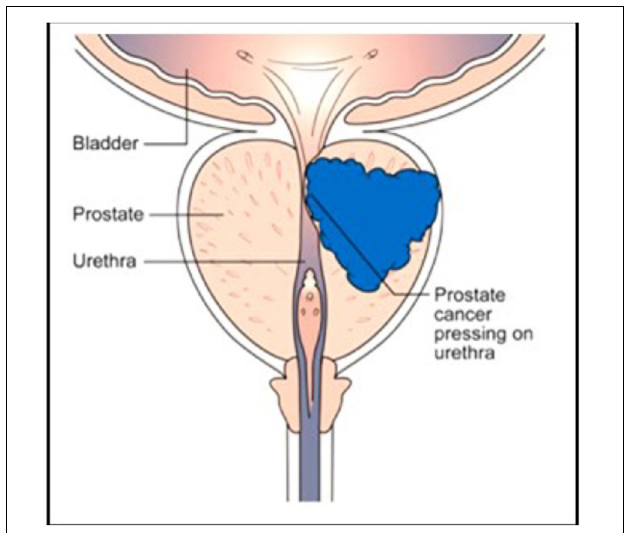
FIGURE 10 | The human prostate: normal healthy gland (left side) and with a developing tumor (right side). Thanks to Cancer Research United Kingdom for the free use. No copyright permission